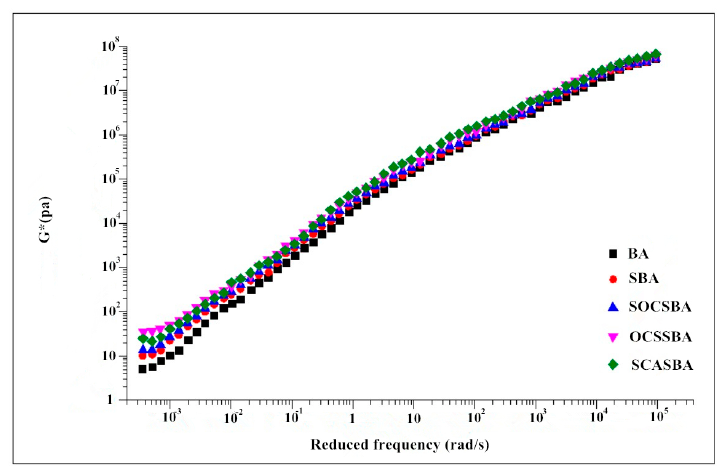
Figure 16. Complex shear modulus master curves for five asphalt binders.